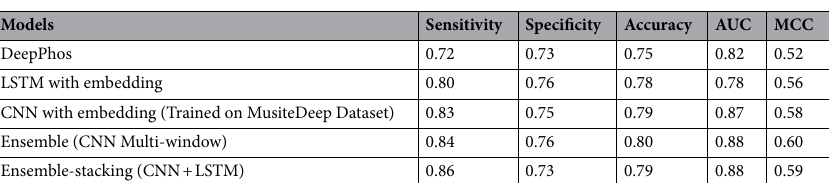
Table 4. Performance metrics of different models using an independent test dataset for general phosphorylation sites S and T.